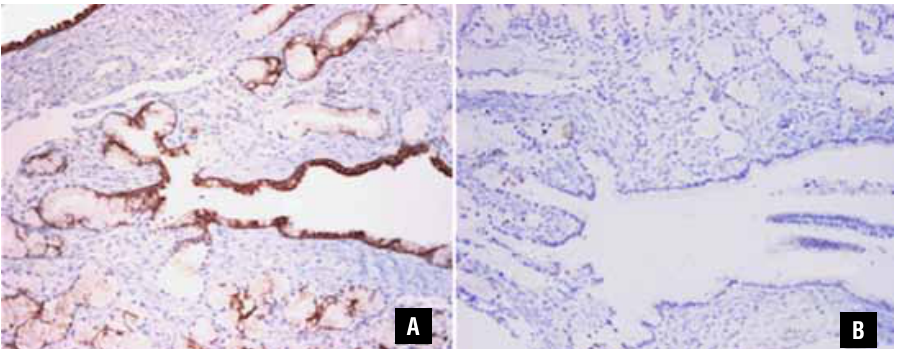
Figure 4 - Immunohistochemistry. (A) High molecular weight keratin (34betaE12) is expressed in normal and dilated glands (10x); (B) while PsA is negative in both